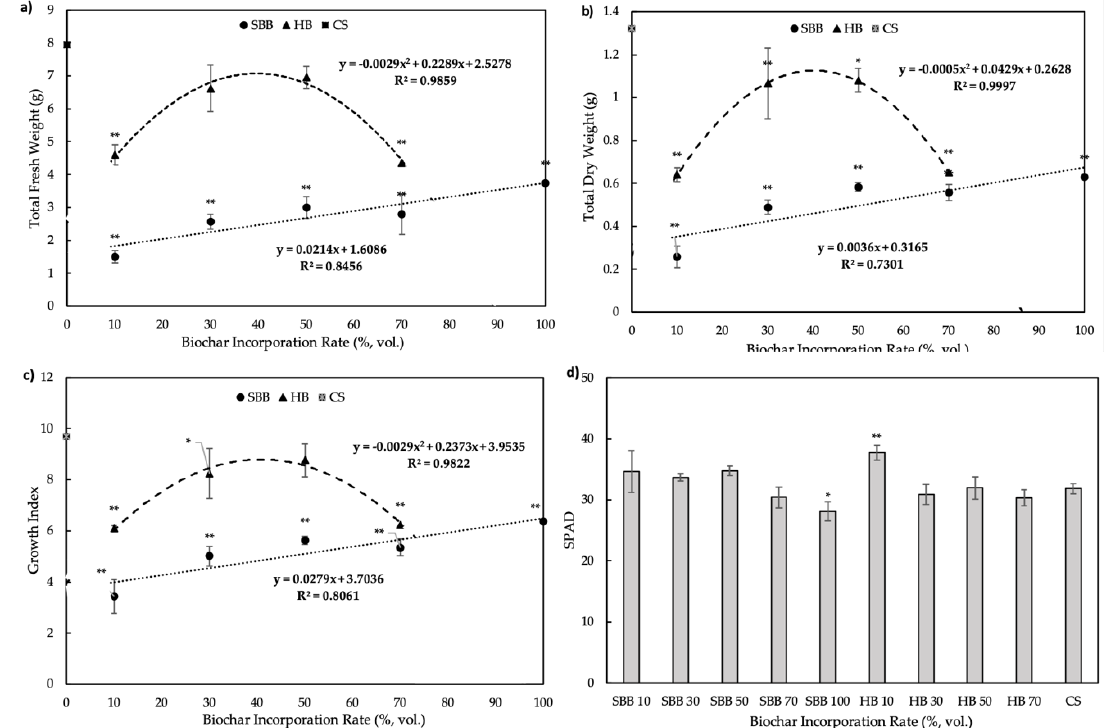
Figure 5. The correlations between total fresh weight (TFW, a) , total dry weight (TDW, b) , growth index (GI, c) and biochar incorporation rate and the SPAD (d) of basil seedlings grown in biochar-amended mixes. SBB = sugarcane bagasse biochar; HB = mixed hardwood biochar; CS = commercial propagation substrate. SBB (10%, 30%, 50%, 70% and 100%; by vol.) incorporated with 30% perlite with the rest being peat moss; HB (10%, 30%, 50% and 70%; by vol.) incorporated with peat moss. (*, ** indicate a significant difference from the control using Dunnett’s test at P ≤ 0.05 and P ≤ 0.01,